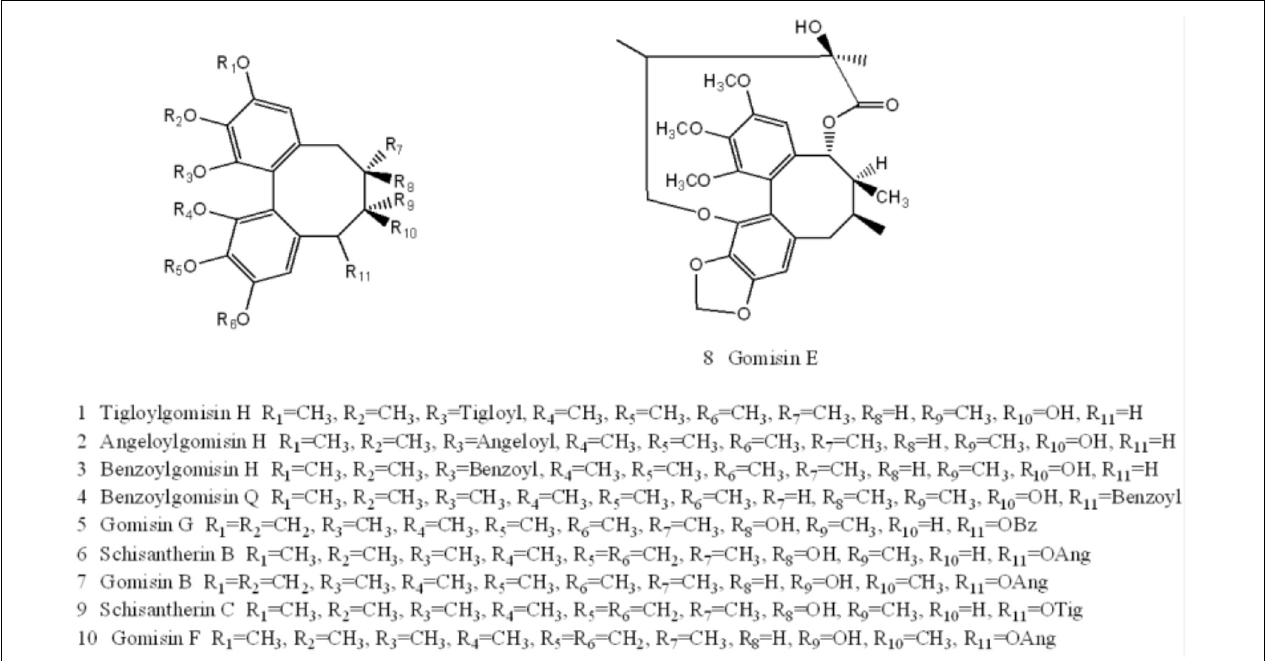
FIGURE 4 | Structures of ten components identified in Schisandra extract: Tigloylgomisin H (1), Angeloylgomisin H (2), Benzoylgomisin H (3), Benzoylgomisin Q (4), Gomisin G (5), Schizantherin B (6), Gomisin B (7), Gomisin E (8), Schizantherin C (9), Gomisin F (10).